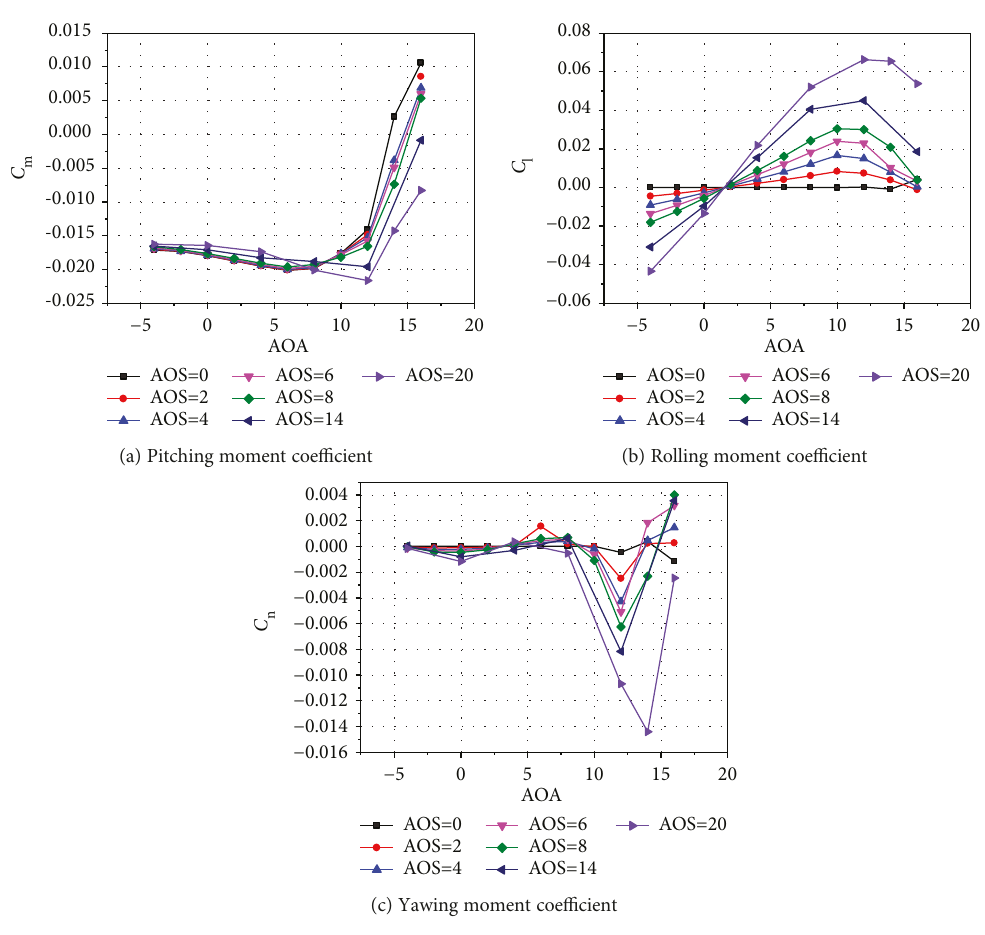
Figure 9: Pitching, rolling, and yawing moment coe ffi cient for angle of